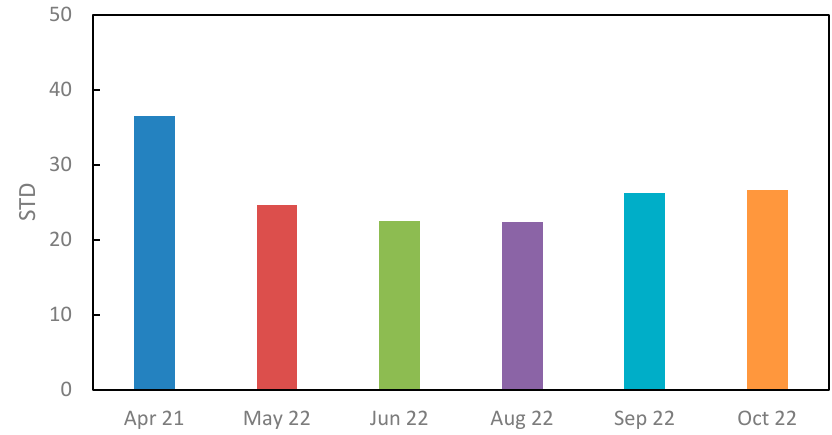
Figure 6. Variability in UAV orthomosaics for April, May, June, August, September, and October.